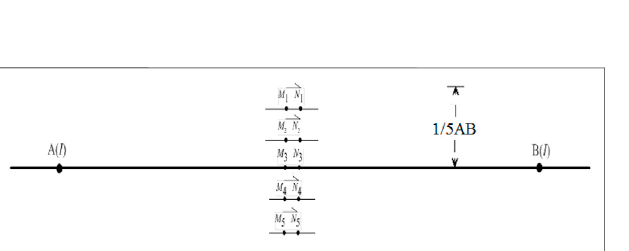
FIGURE 4 | Geological map and distribution of the bauxite deposits in western Henan Province (modi fi ed after Li and Li, 2019).